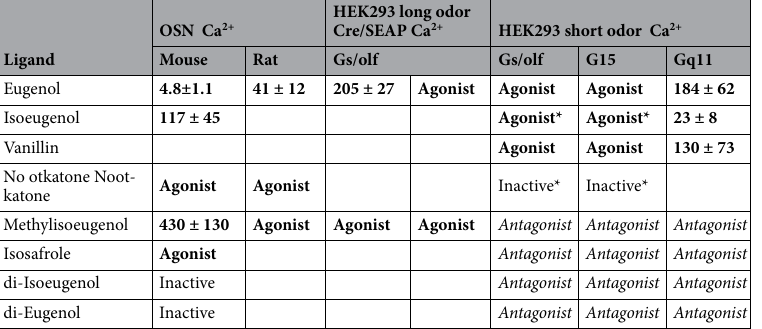
Table 1. Agonism and antagonism of several ligands of mouse Olfr73 is dependent on the assay and stimulation. Changes of intracellular Ca 2+ were used to measure activation of mammalian Olfr73-OSNs evoked by a short 5-s odorant pulse. Cre/SEAP reporter assay or cAMP-dependent influx of Ca 2+ were used to measure activation of HEK293 cells expressing Olfr73 following prolonged 30-min and 10-min odorant application, respectively. Changes of intracellular Ca 2+ were used to measure activation of HEK293 cells expressing Olfr73 coupled to a respective G-protein and following a short 5-s odorant pulse. EC 50 values (µM ± SD) of several ligands are shown in the respective boxes. Ligands which showed agonism on Olfr73 are labeled in bold and those showed antagonism are labeled in italic. A strong agonist (eugenol, vanillin) was presented at 100 µM and a putative antagonist at 1 mM as a single compound or as a pair mixed at these concentrations. *For comparison purpose isoeugenol and nootkatone were listed as agonist and inactive odorant based on the previously published in vitro work 25 , performed under the same conditions as in the current